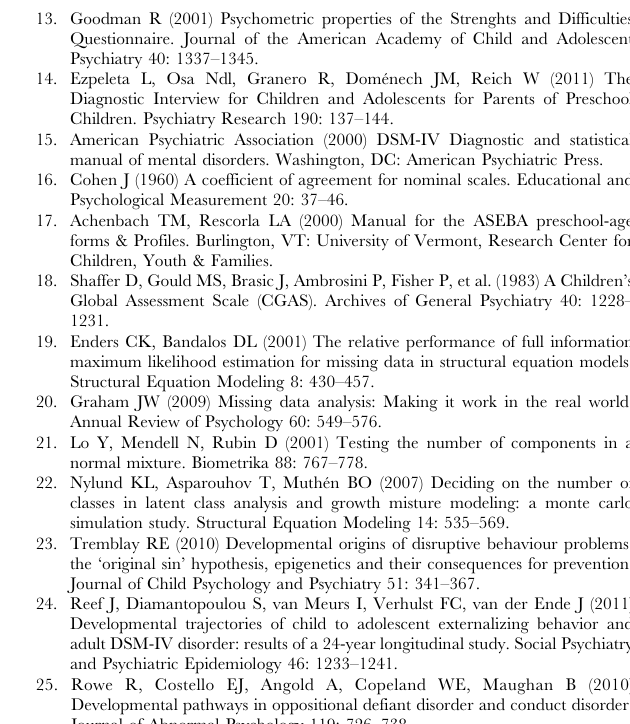
Table S1 Demographic Characteristics of the Sample ( N = 622). Table S2 Fitting Indices for Growth-Mixture-Modeling. Table S3 Comparison between Trajectories on Out- comes at Age 6. Table S4 Item content of the scales used for the trajectories in each